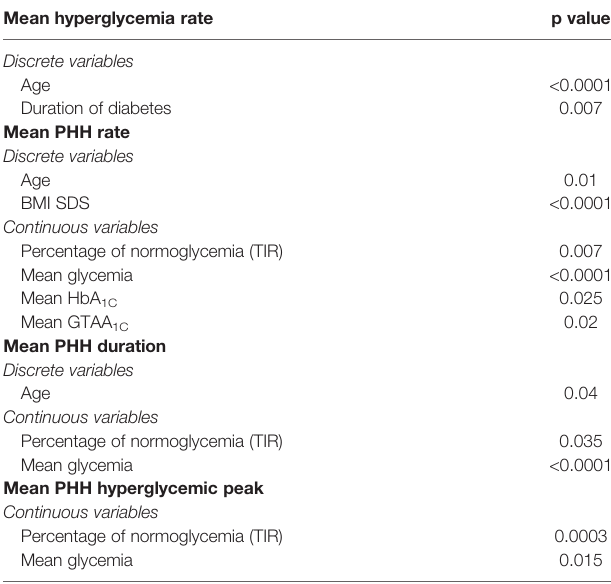
TABLE 3 | Multivariate analysis of parameters in fl uencing mean PHH rate, duration and hyperglycemic peak, and mean hyperglycemia rate. Mean hyperglycemia